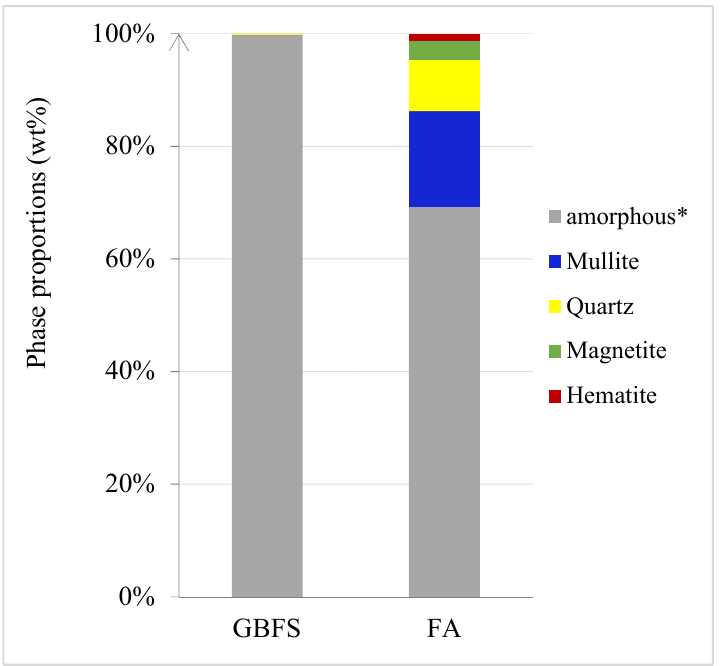
Figure 3. Quantitative phase analysis with the Rietveld method for the unreacted GBFS and FA. * stands for proportion of amorphous phase when excluding the internal standard in QXRD calcula- tions. Table 2. Mixture design for pastes with respect to 100 g of binder.